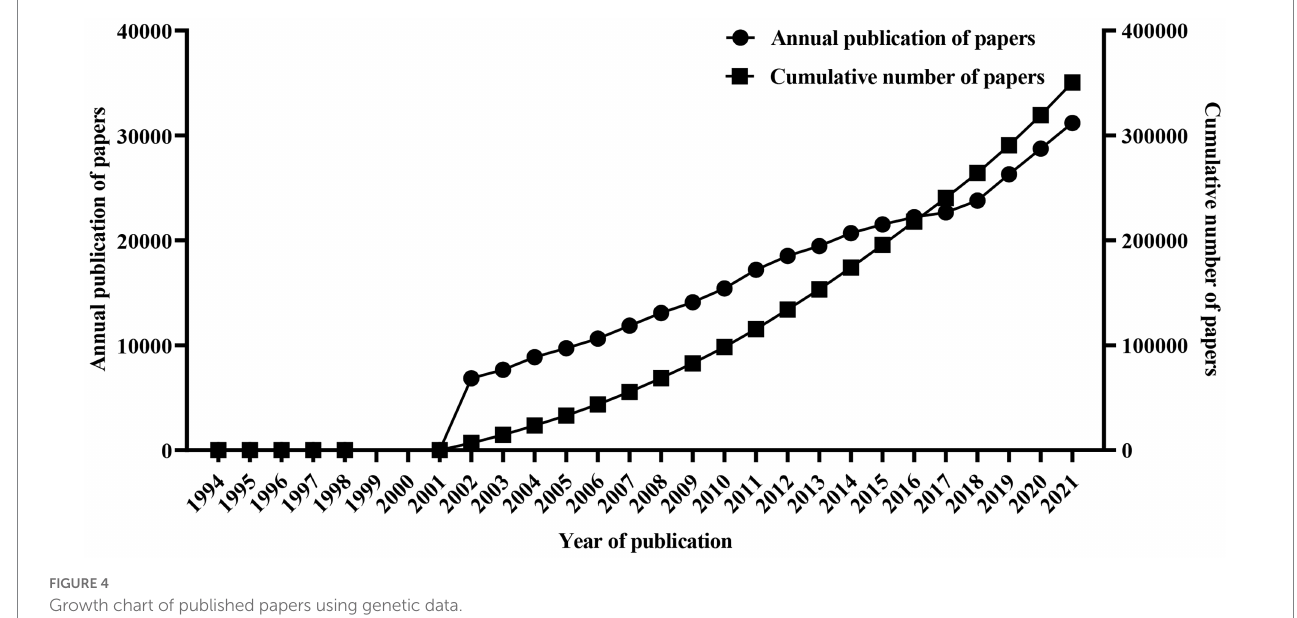
FIGURE 4 Growth chart of published papers using genetic data.